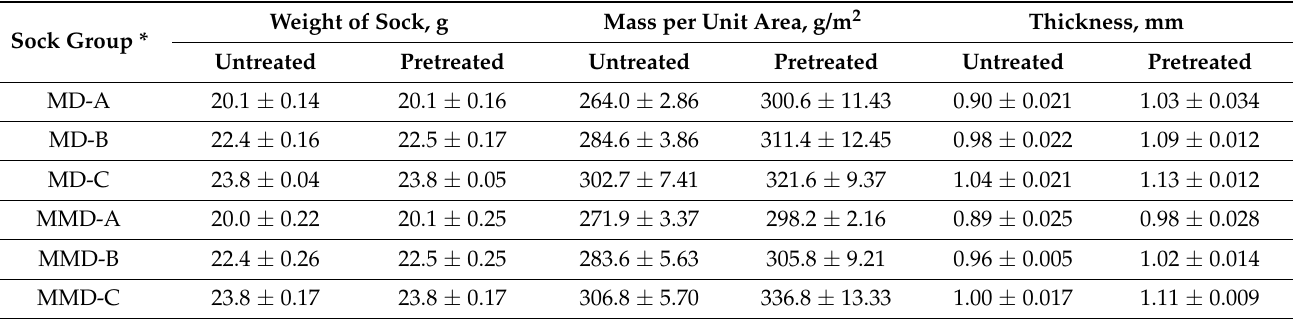
Table 5. Mean values of the physical properties calculated for groups A, B and C of the untreated and pretreated socks made from differently spun modal and micro modal